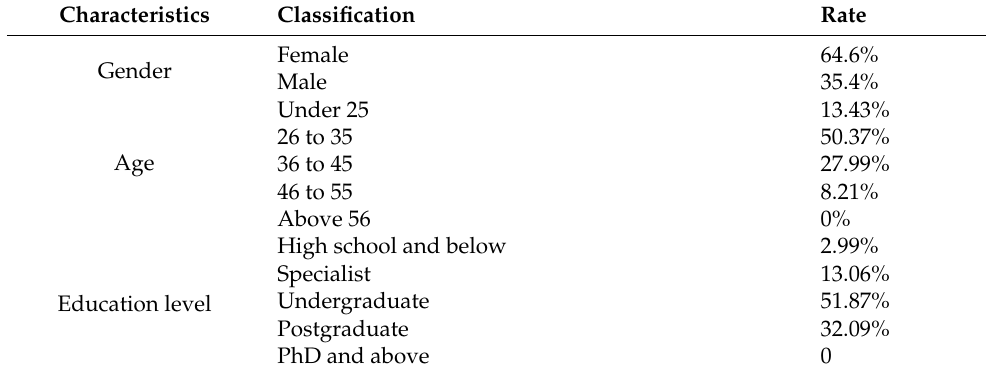
Table 2. Demographic